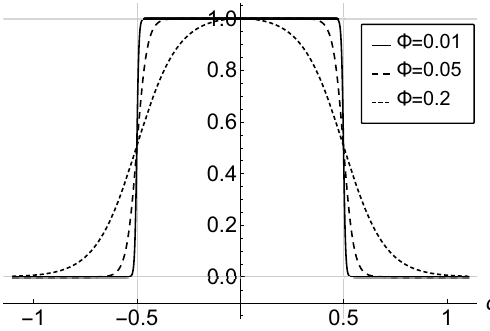
Figure 3 . Magnetic part of a constant crossed (cid:12)eld, scaled so the maximum is unity. For highly- relativistic axions, the crossed (cid:12)eld produces an equivalent e(cid:11)ect to entering a constant homogeneous magnetic (cid:12)eld. The limit (cid:8) ! 0 gives the top-hat function.